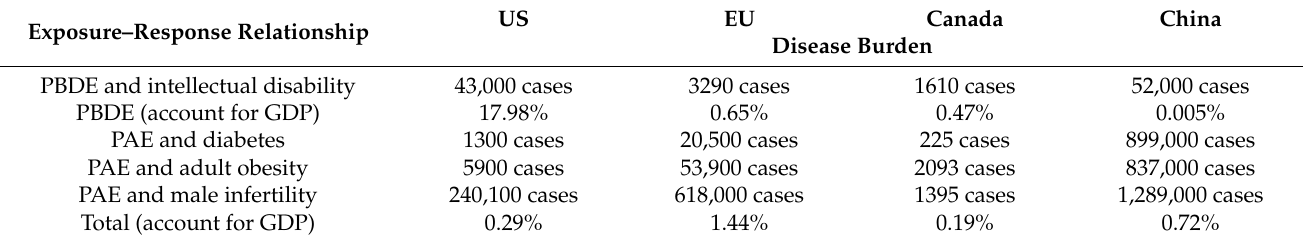
Table 4. Comparison of the attributable disease burden between China (2015) and the US, the EU, and Canada